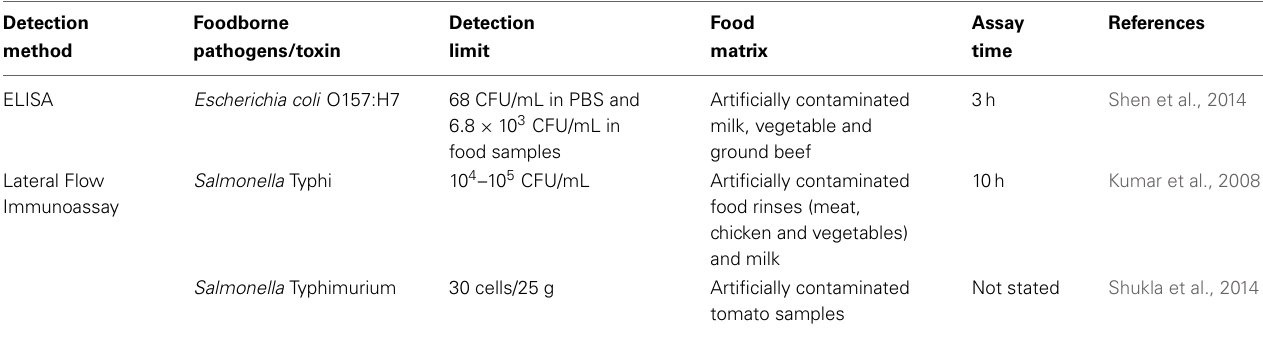
Table 3 | Examples of the application of immunological-based methods for the detection of various foodborne pathogens present in food